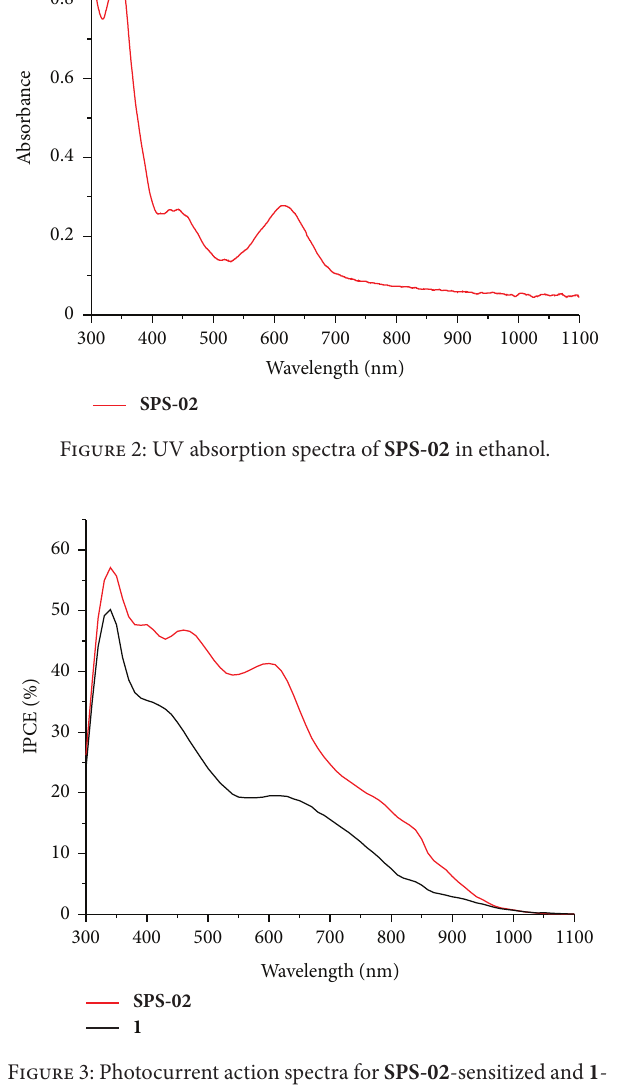
F 3: Photocurrent action spectra for SPS-02 -sensitized and 1 - sensitized �lms of TiO